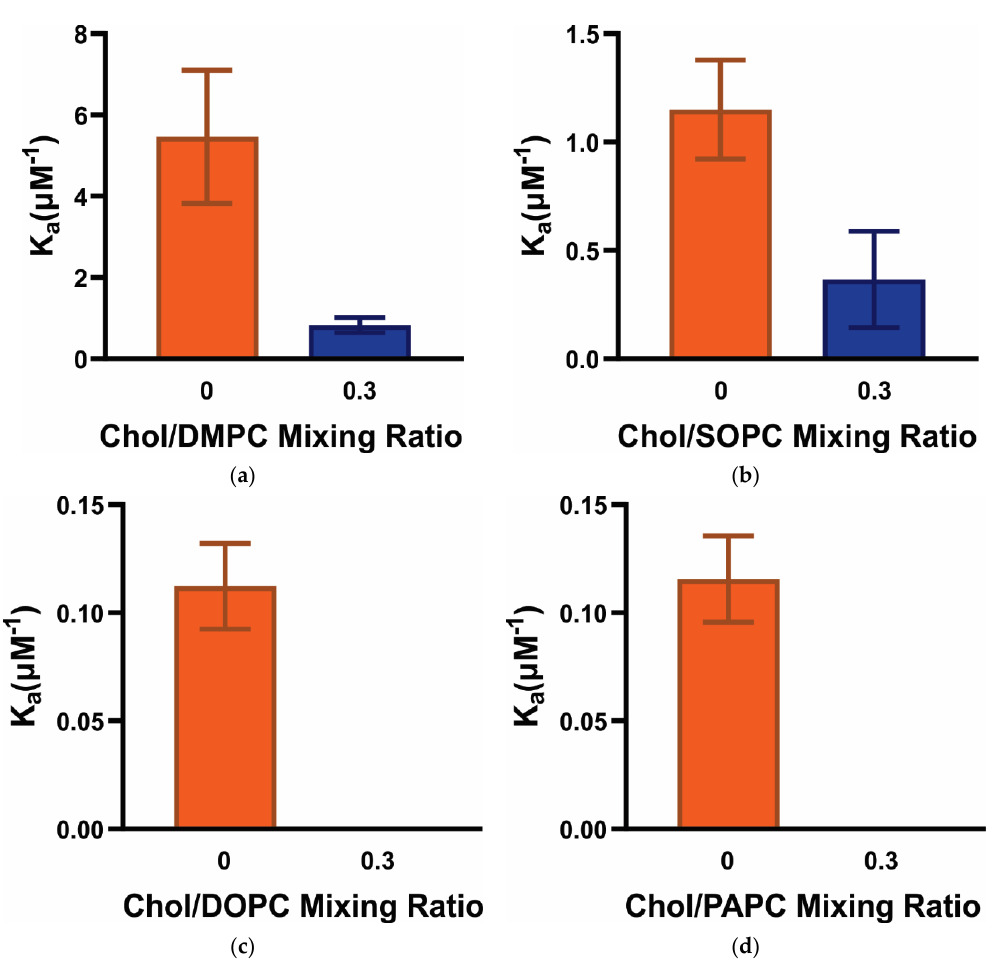
Figure 3. ( a − d ) Show the association constant (K a ) of α -crystallin association with Chol/DMPC, Chol/SOPC, Chol/DOPC, and Chol/PAPC membranes, respectively, at Chol and PL mixing